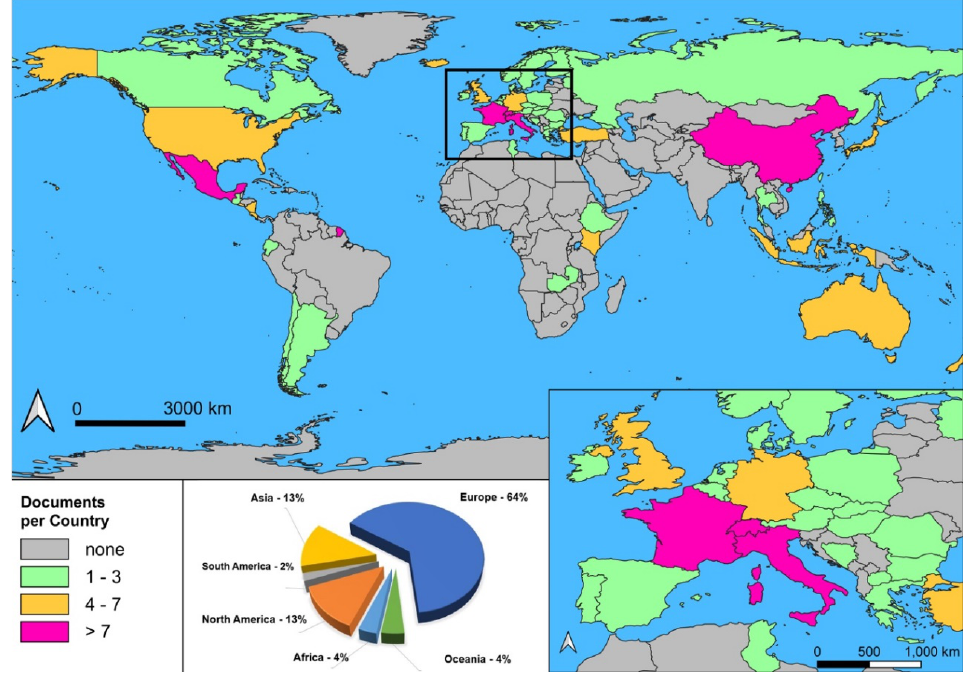
Figure 1. National occurrence map of selected documents and continental percentage. National (or subnational) and international (more than one country involved) documents were considered.